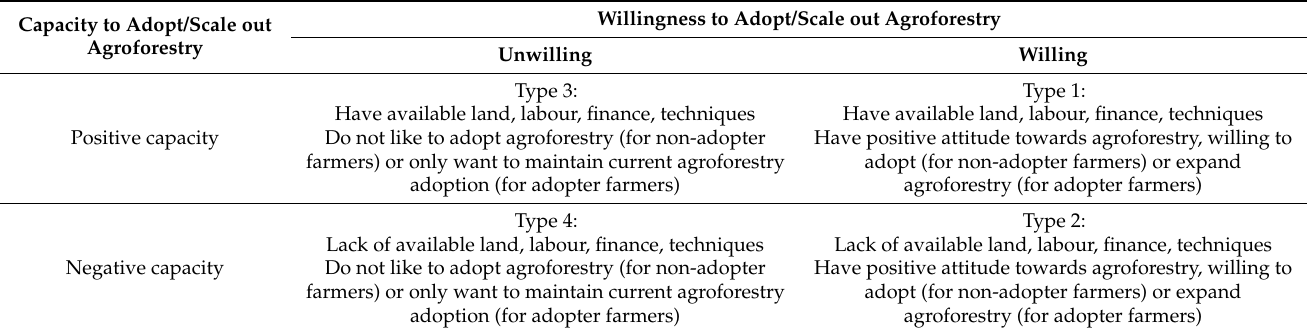
Table 3. Farmer characterisations based on capacity and willingness to adopt/scale out agroforestry. Capacity to Adopt/Scale out